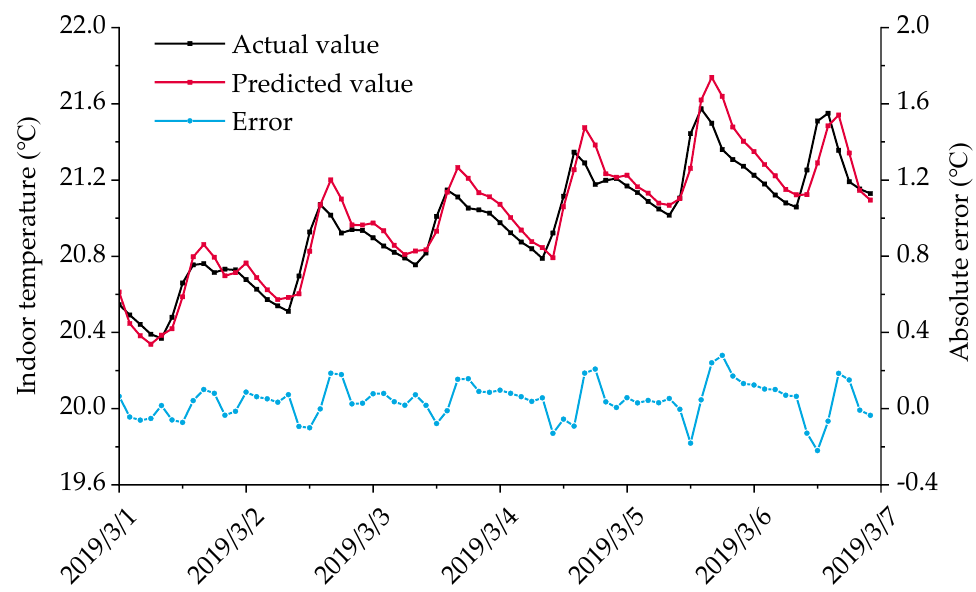
Figure 11. Comparison of measured and predicted indoor temperatures.